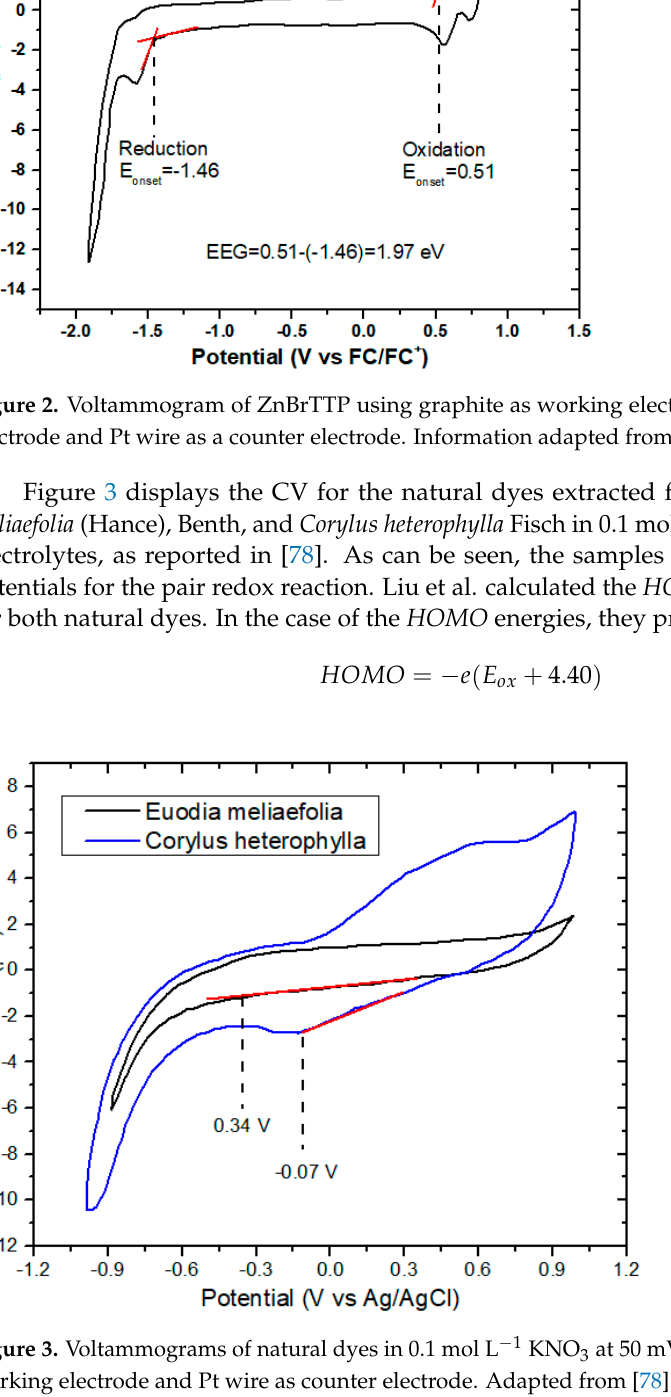
Figure 2. Voltammogram of ZnBrTTP using graphite as working electrode and Ag/AgCl counter electrode and Pt wire as a counter electrode. Information adapted from [76].